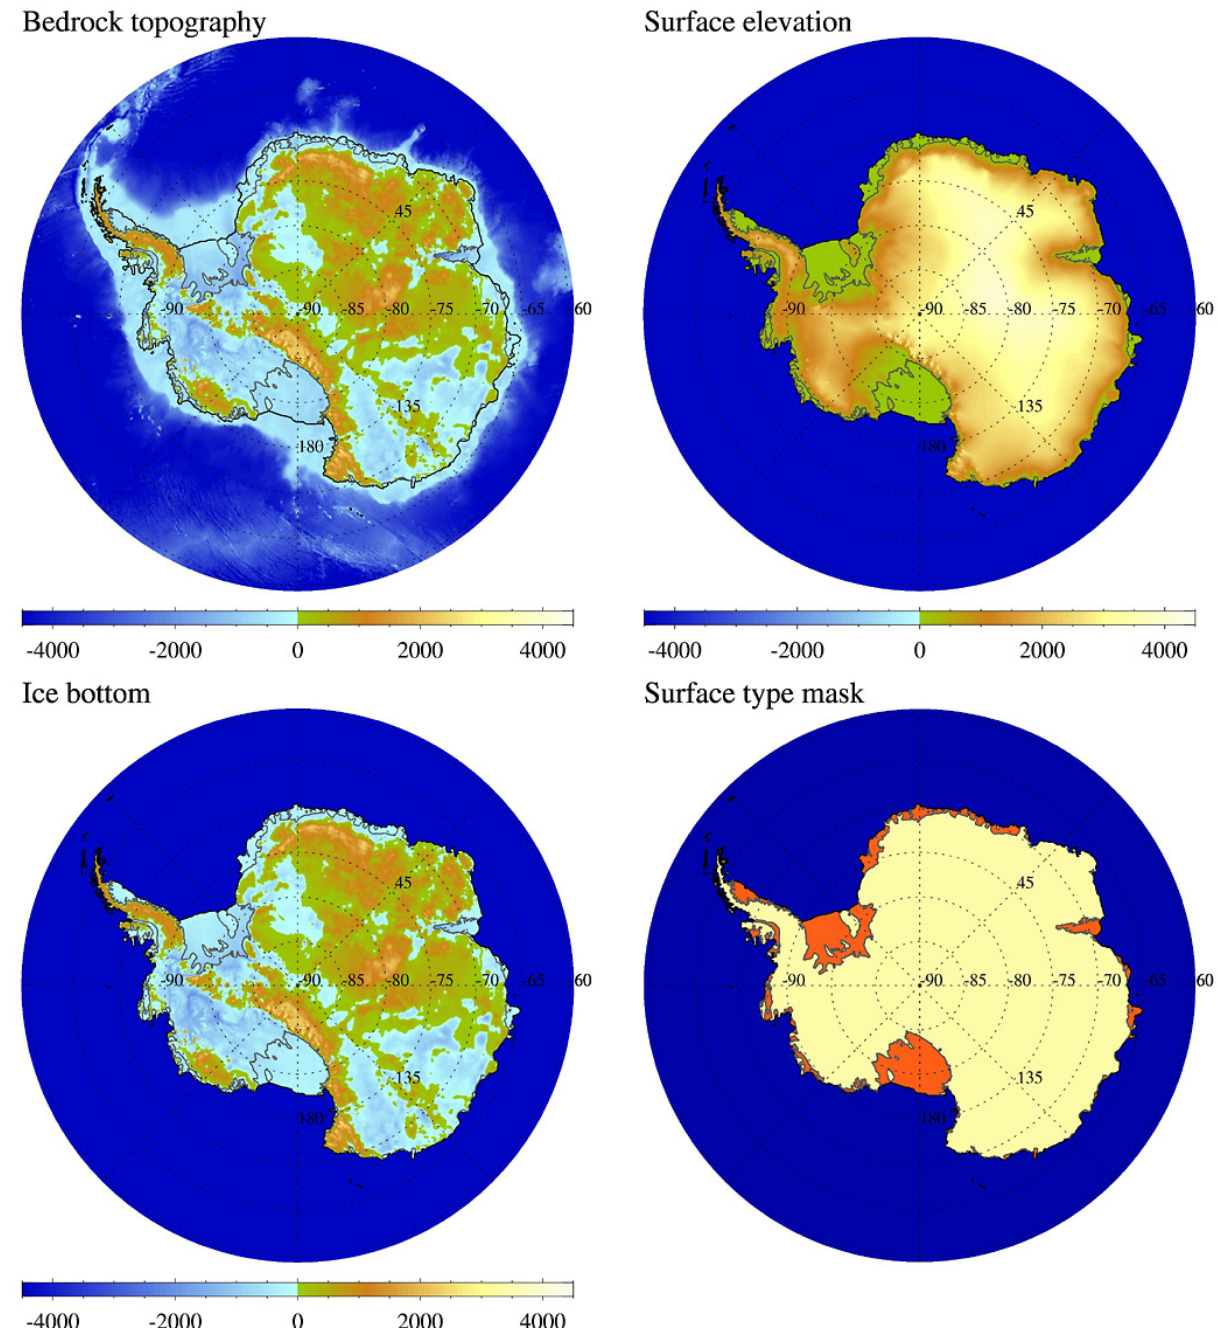
Figure 2. Antarctic subset of the RTopo-1 data set. Top left: Bedrock topography (ocean bathymetry). Top right: surface elevation. Bottom left: ice bottom surface height (including ice shelf draft). Bottom right: surface type mask, blue = ocean, yellow = grounded ice, orange = floating ice, grey = bare bedrock (appears only on the islands close to the Antarctic Peninsula here). Grey line marks the grounding line, black line the ice shelf front or